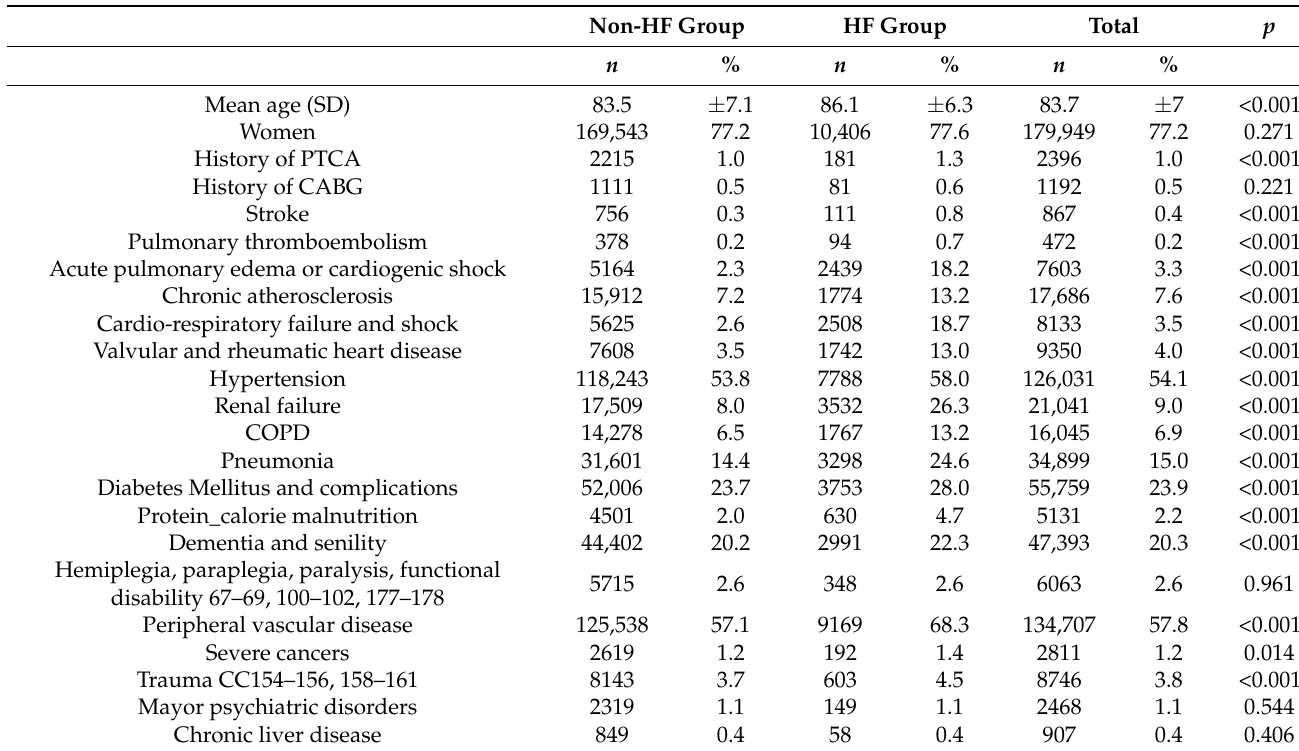
Table 2. Clinical and demographic characteristics according to the presence of heart failure.